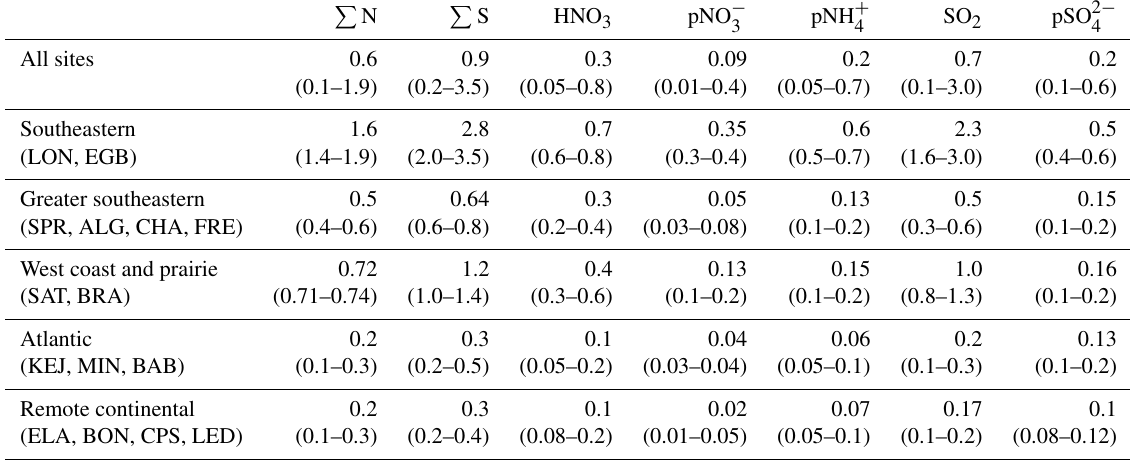
Table 1. Regional breakdown of annual mean dry deposition fluxes of N and S (kgN or Sha − 1 yr − 1 ) across Canada for the 2000–2018